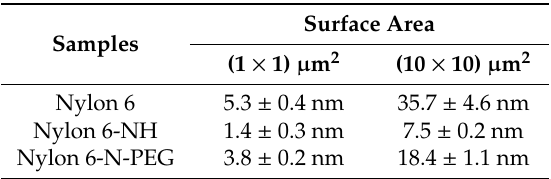
Table 1. Changes in the surface roughness (Ra) observed before and after immobilization of the Nylon 6 surface.